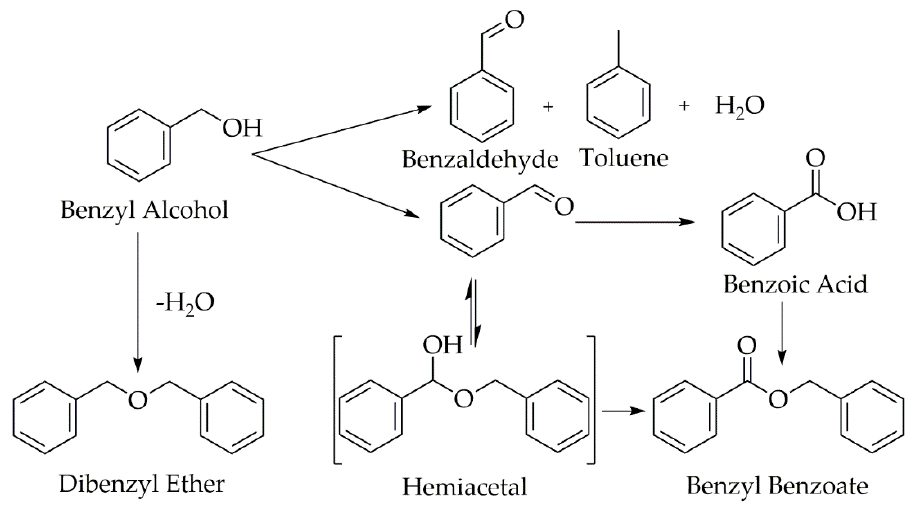
Figure 1. Reaction mechanism for the oxidation of benzyl alcohol.